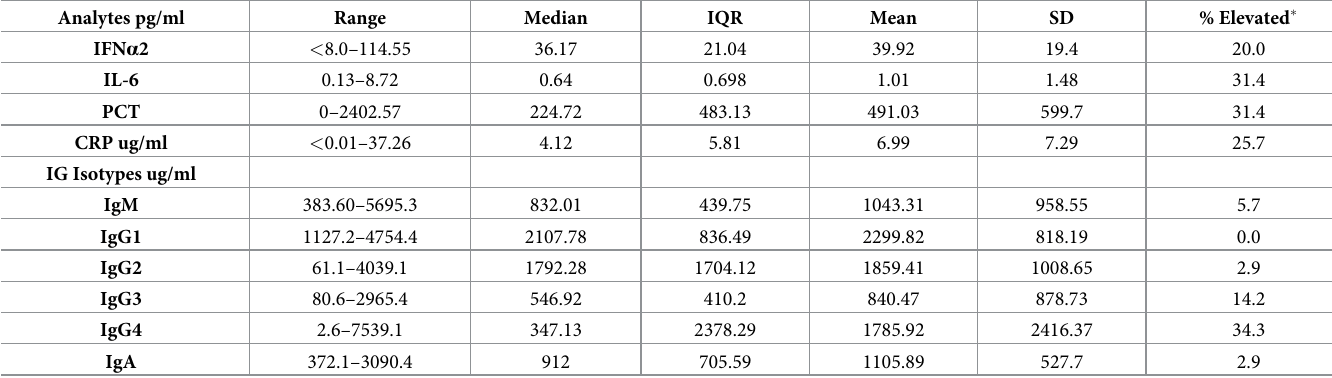
Table 2. Summary of Donor Plasma Luminex Analyses. Analytes